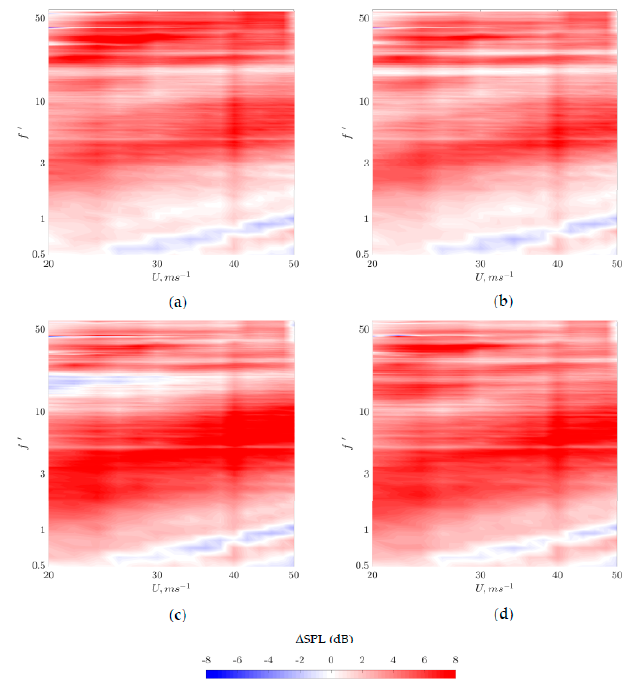
Figure 8. Comparison of Δ SPL as a function of f ‘ and U at α = 0° produced by the serrated leading edges ( a ) λ 5 A 15; ( b ) λ 10 A 15; ( c ) λ 5 A 30; and ( d ) λ 10 A 30.